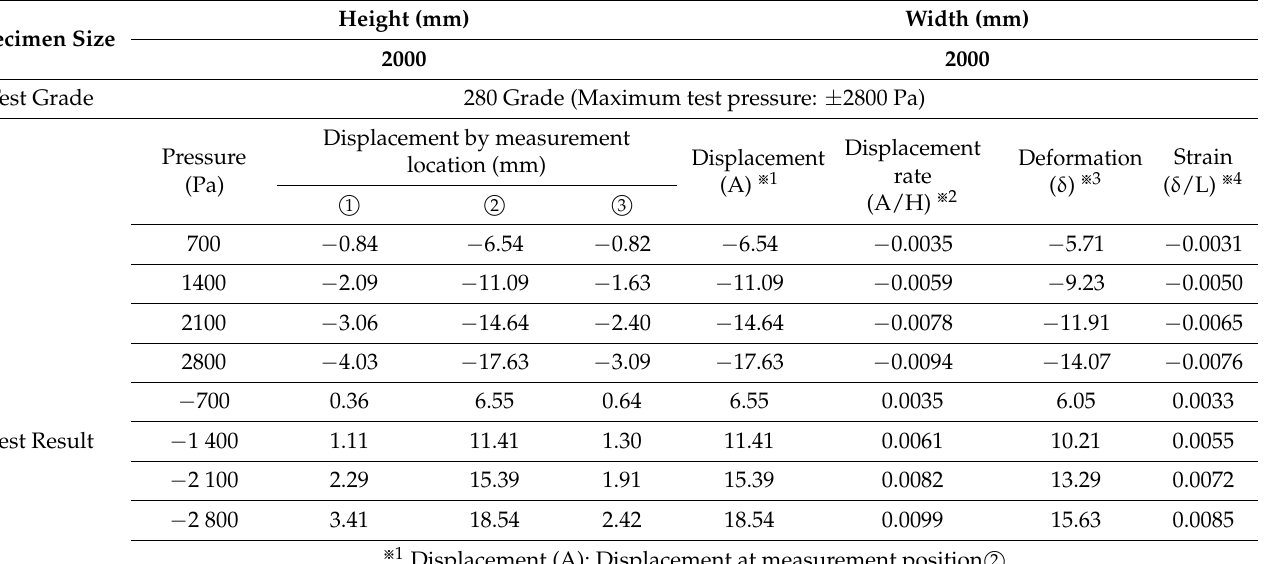
Table 16. Wind resistance test results.